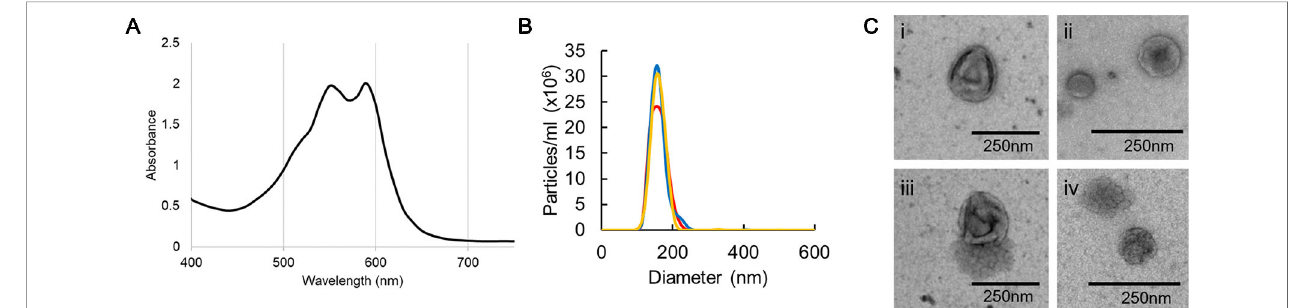
FIGURE 1 | Characterization of EVs isolated from F. oxysporum f. sp. vasinfectum . EVs were isolated using differential centrifugation followed by ultracentrifugation. (A) Absorption spectrum of the F. oxysporum f. sp. vasinfectum EV preparation had dual maxima at 550 and 590 nm. Data are representative of three independent replicates. (B) The number and size distribution of the isolated EVs were determined using nanoparticle tracking analysis. The data from the three technical replicates from one biological sample are representative of all samples used in this study. The average quantity and size of EVs from three independent isolations of EVs from F. oxysporum f. sp. vasinfectum were 1.0 x 10 12 ± 2.8 x 10 11 particles/ml of culture, mean diameter 155.1 nm ± 3.5 nm, mode diameter 150.0 nm ± 5.1 nm. Values are presented ± standard deviation of three biological replicates. (C) TEM con fi rmed that most particles had the characteristic cup like morphology of EVs (i – iii);